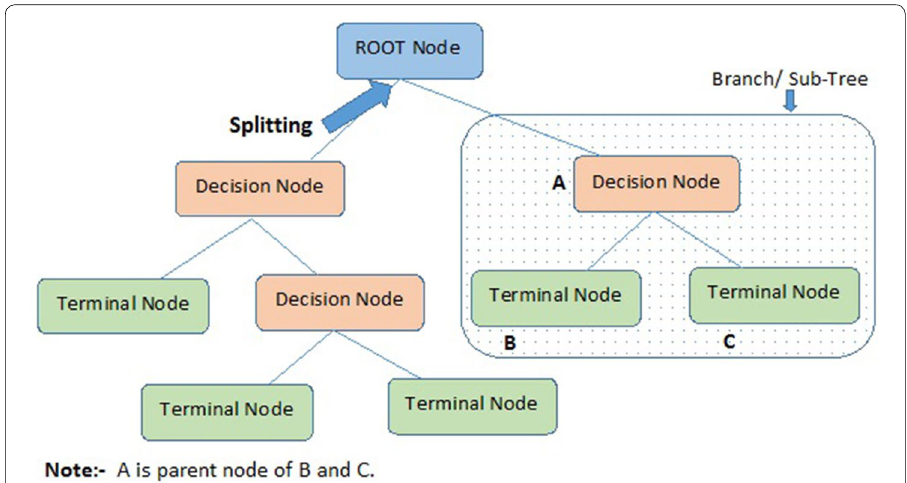
Fig. 3 Model for decision